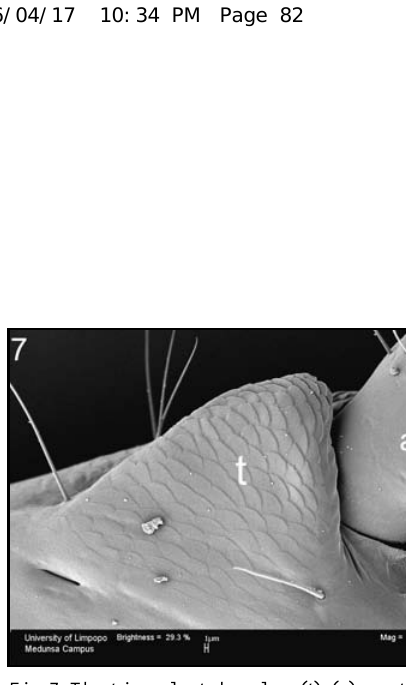
openings.Fig. 7. The triangular trabeculum (t). (a) =